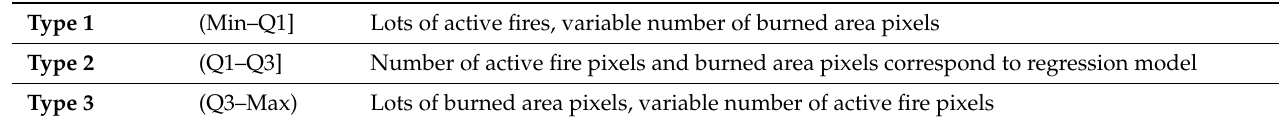
Table 3. Typology of different fire spread